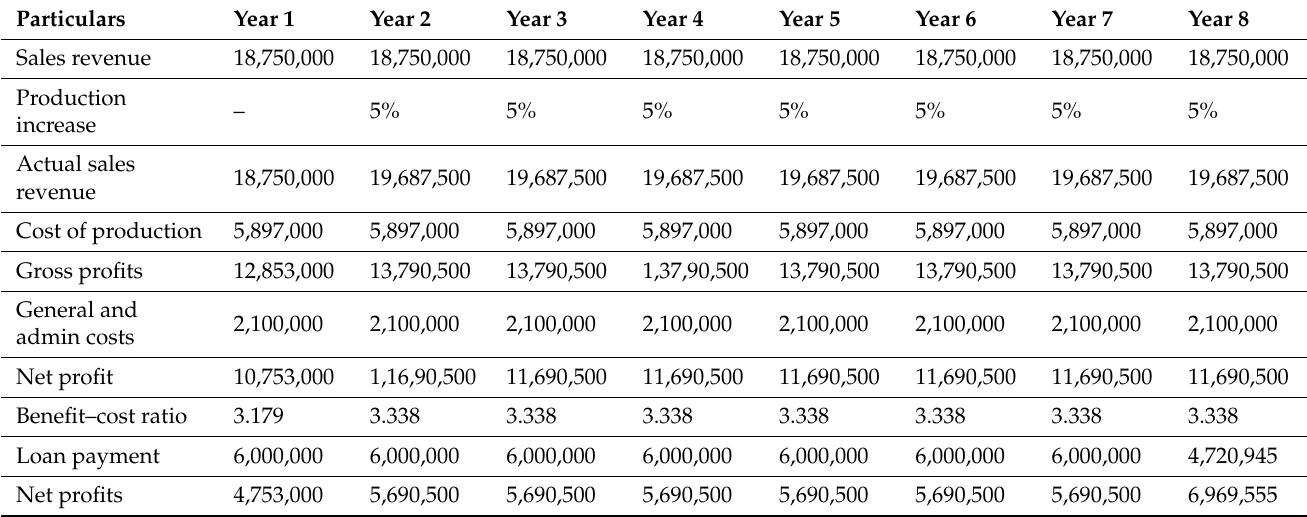
Table 4. Estimation of gross profits, net profits, benefit–cost ratio and loan payment plan (Figures in BDT).